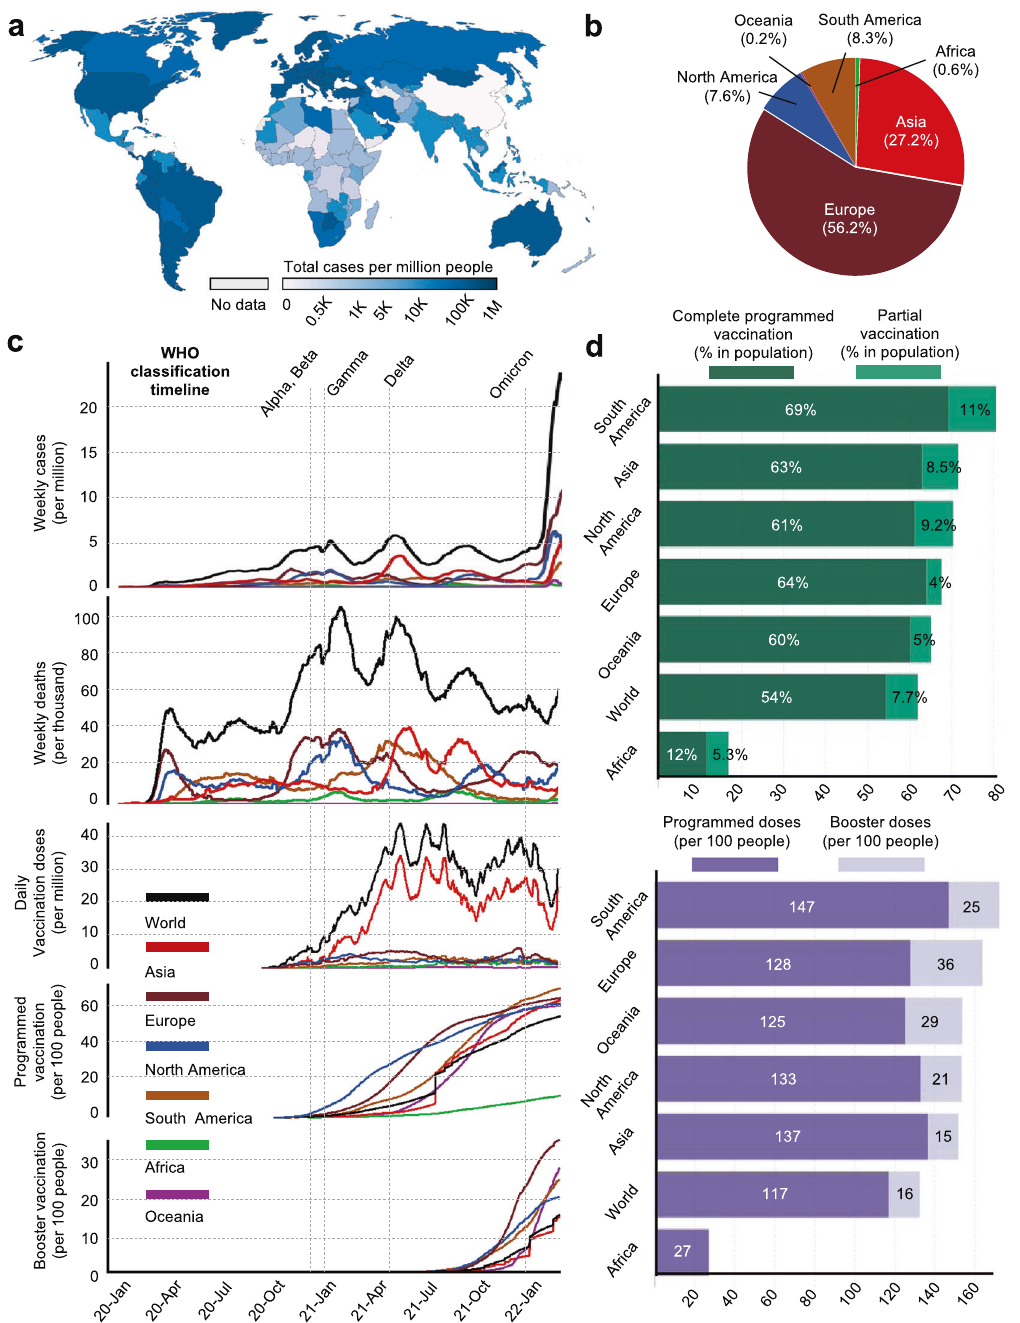
Fig. 9 Epidemiological pro fi le of SARS-CoV-2 infection and populational vaccination. a The global distribution of accumulated con fi rmed COVID-19 cases was reported by the WHO COVID-19 dashboard in February 2022. b The aligned trend of global weekly cases per million people, weekly death per million people, daily vaccination doses per million people, the proportion of programmed vaccination per 100 people, and proportion of booster vaccination per 100 people from January 2020 to February 2022. The timeline of emergent VOC by WHO classi fi cation is marked, and the regional data curve is colored differently. c The regional proportion of emerging cases of COVID-19 in February 2022. d The regional data of applied doses for programmed vaccination and booster vaccination. All the data comes from the website Our World in Data (https://ourworldindata.org/coronavirus), WHO COVID-19 dashboard (https://covid19.who.int/), and the fi gures in related are generated under the CC-BY 4.0 permission